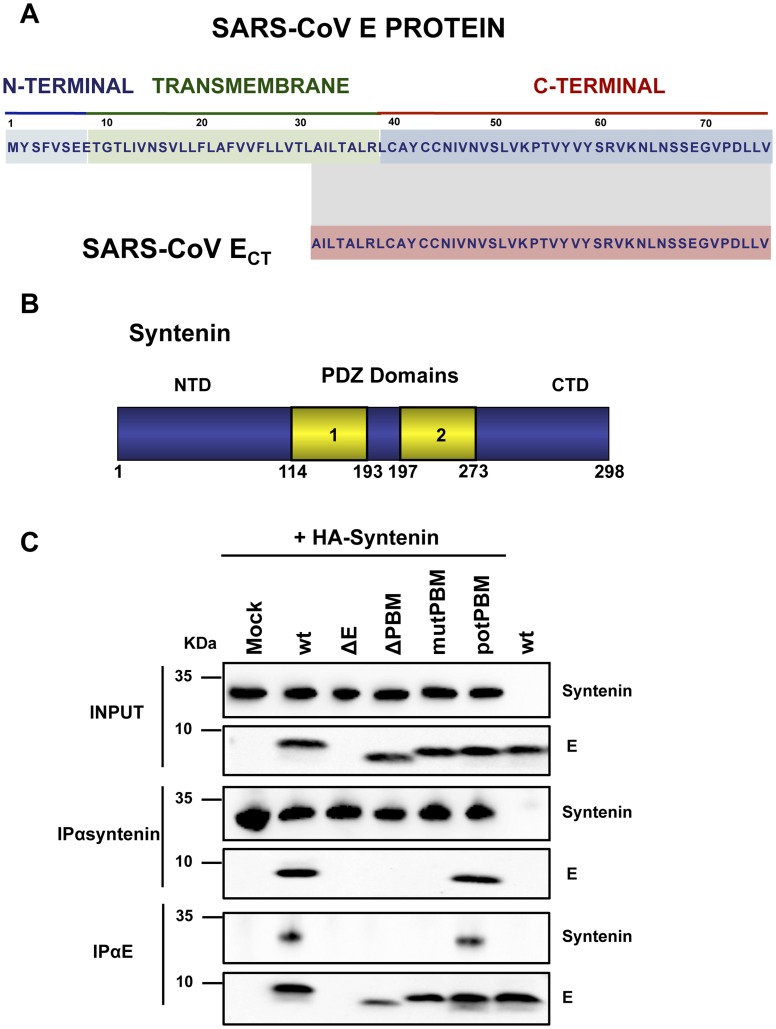
Interaction of SARS-CoV E protein with cellular syntenin.(A) Sequence of SARS-CoV E protein and the region containing amino acids 36–76 (SARS-CoV ECT) that was used as bait for the yeast two-hybrid screening. (B) Schematic representation of syntenin. Numbers at the bottom indicate the amino acids at the beginning and the end of the different domains. NTD; N-terminal domain; CTD, C-terminal domain; PDZ 1 and 2, PDZ domains. (C) Vero E6 cells transfected with a plasmid encoding an N-terminal HA-tagged syntenin were mock-infected (mock) or infected with recombinant viruses containing (wt and potPBM) or lacking (ΔE, PBM and mutPBM) E protein PBM, respectively. As a control, mock-transfected cells were infected with the wt virus (wt, last lane). Cells were lysed and subjected to immunoprecipitation using a monoclonal anti-HA antibody or polyclonal anti-E antibody to pulldown syntenin or E protein, respectively. The presence of E and syntenin proteins was analyzed in the precipitated fractions.